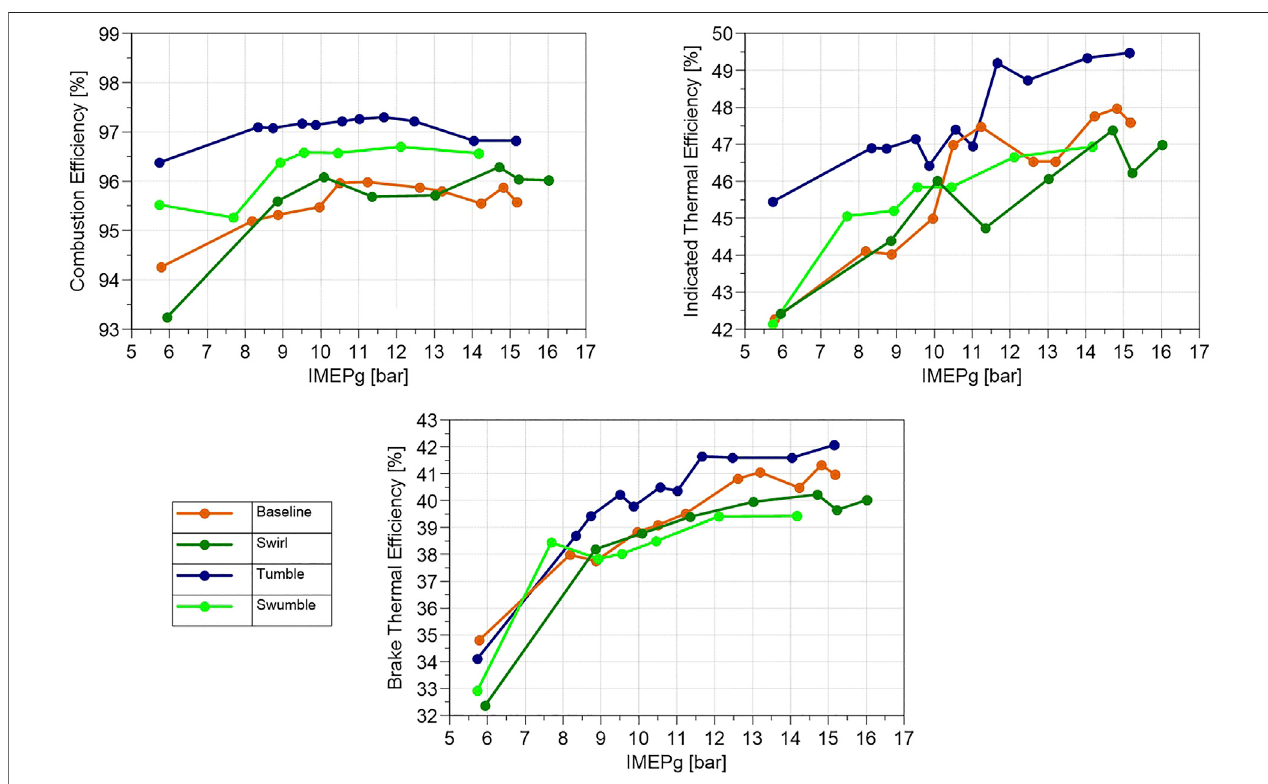
FIGURE 12 | Ef fi ciency metrics vs. IMEPg; 3,000 rpm, lambda (cid:1) 1.65.